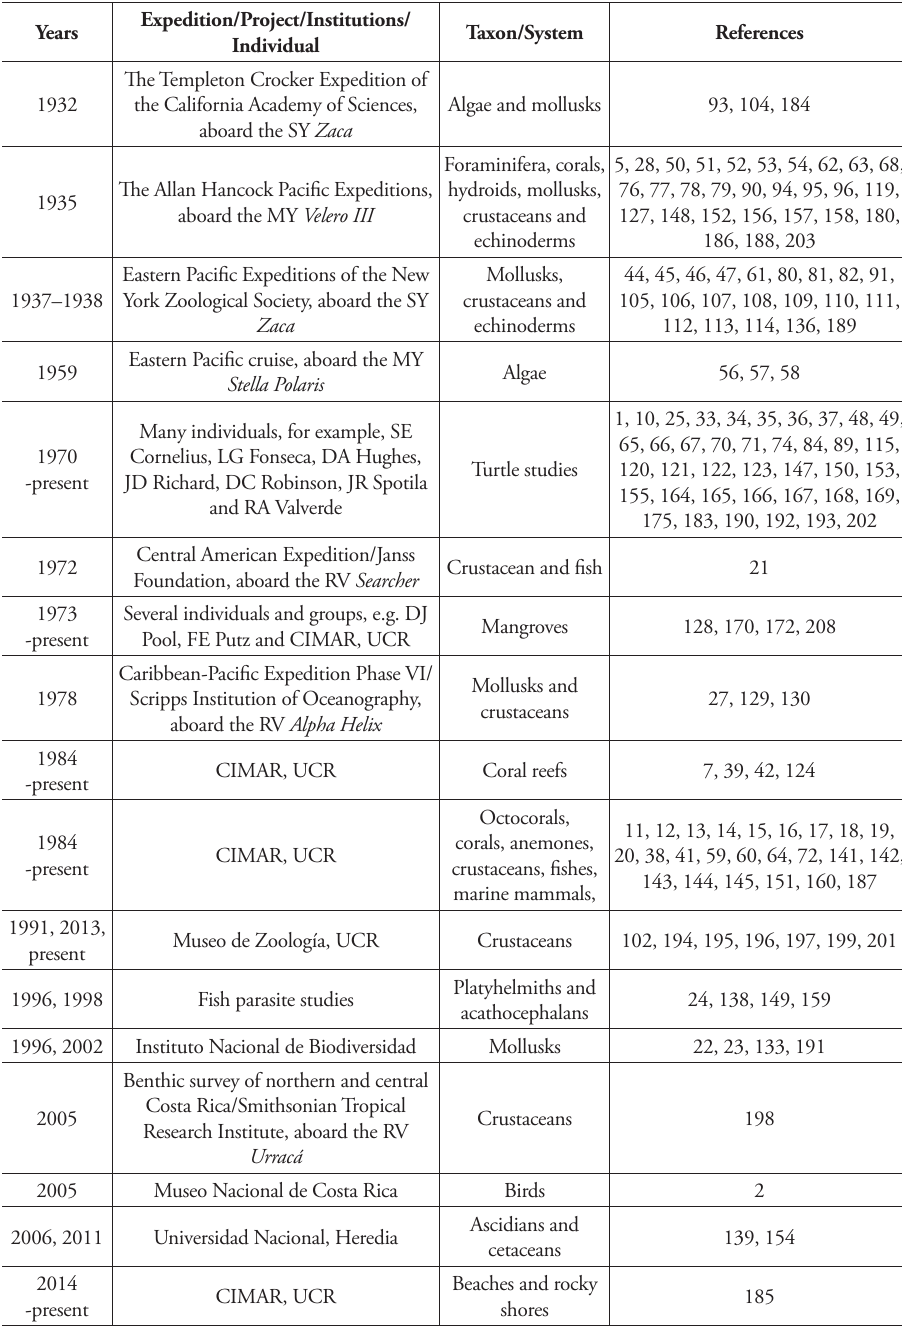
Table 1. Historical account of marine studies at the Área de Conservación Guanacaste, Pacific coast of Costa